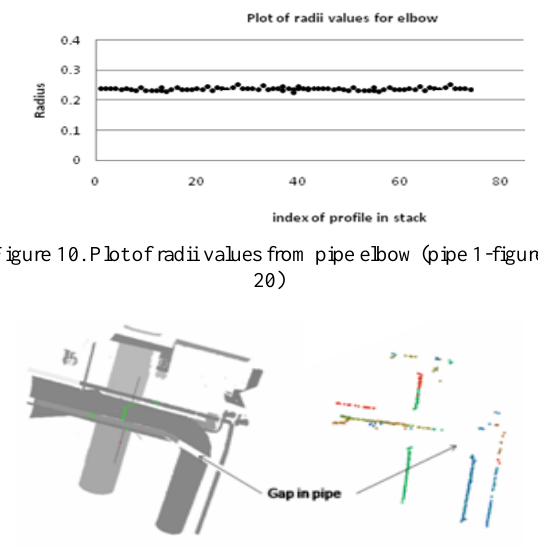
Figure 11. Pipes in point cloud. Various axes are detected from the point cloud. Gaps are be detected by incomplete axis or missing centres.